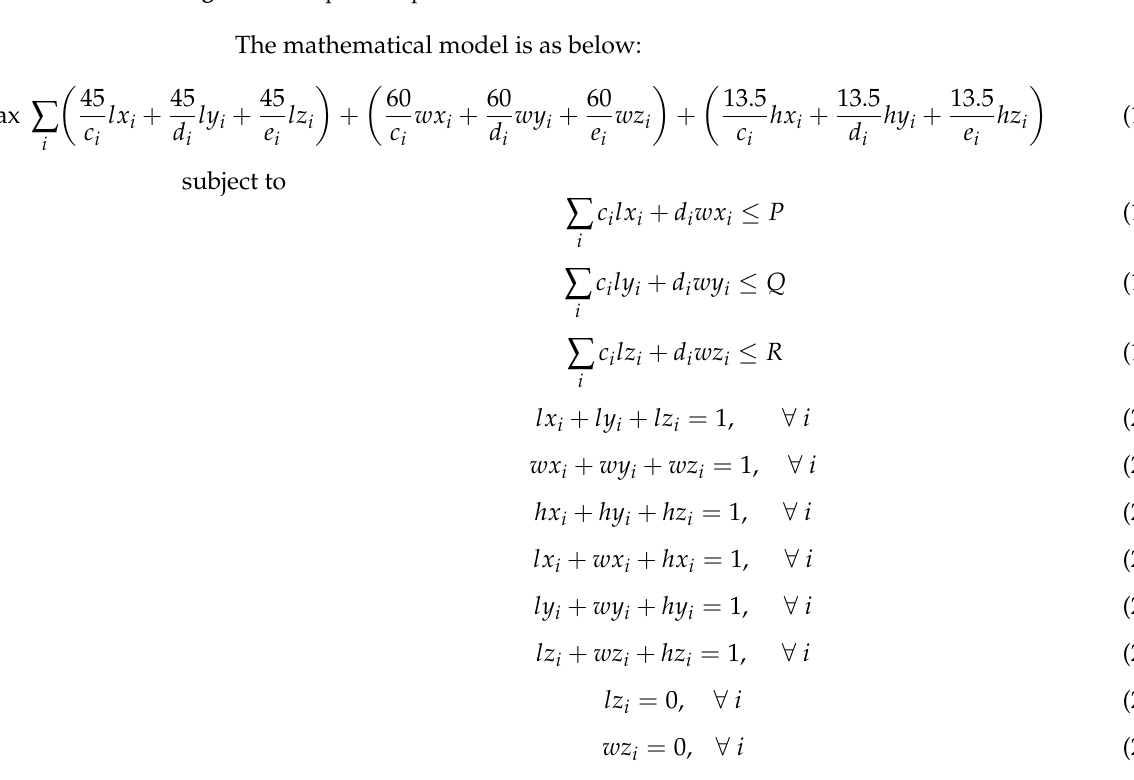
Figure 16. Graphical representation of variables in the model.